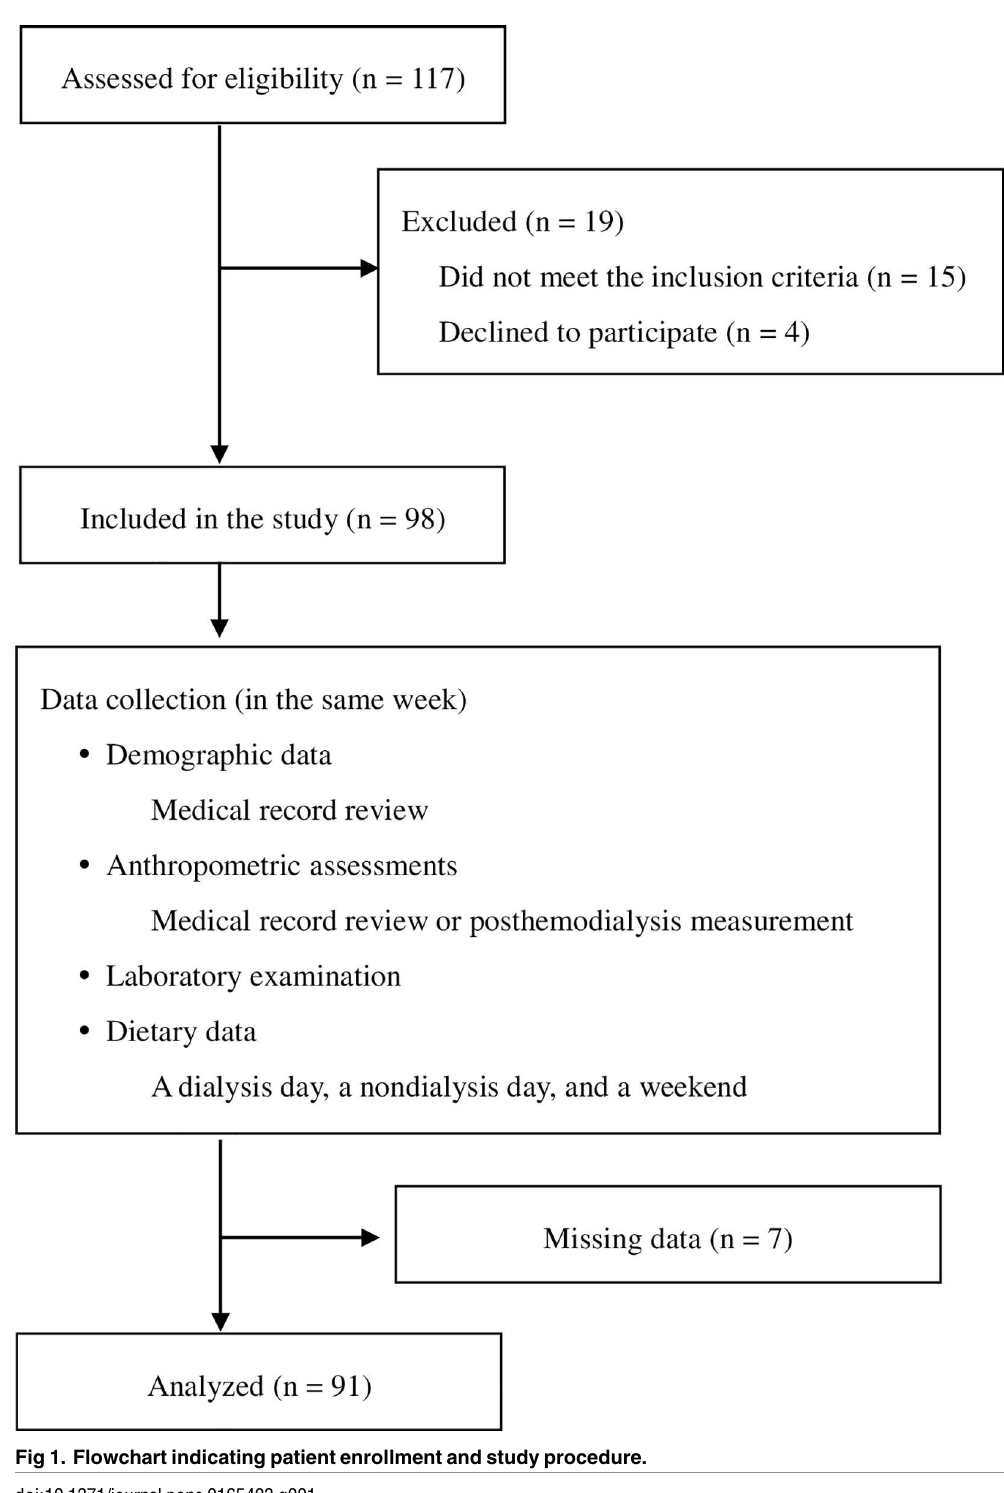
Fig 1. Flowchart indicating patient enrollment and study